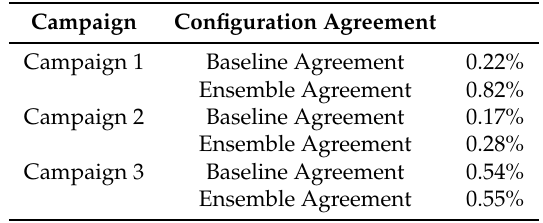
Table 4. Agreement of Explanations by the oracle for Campaigns